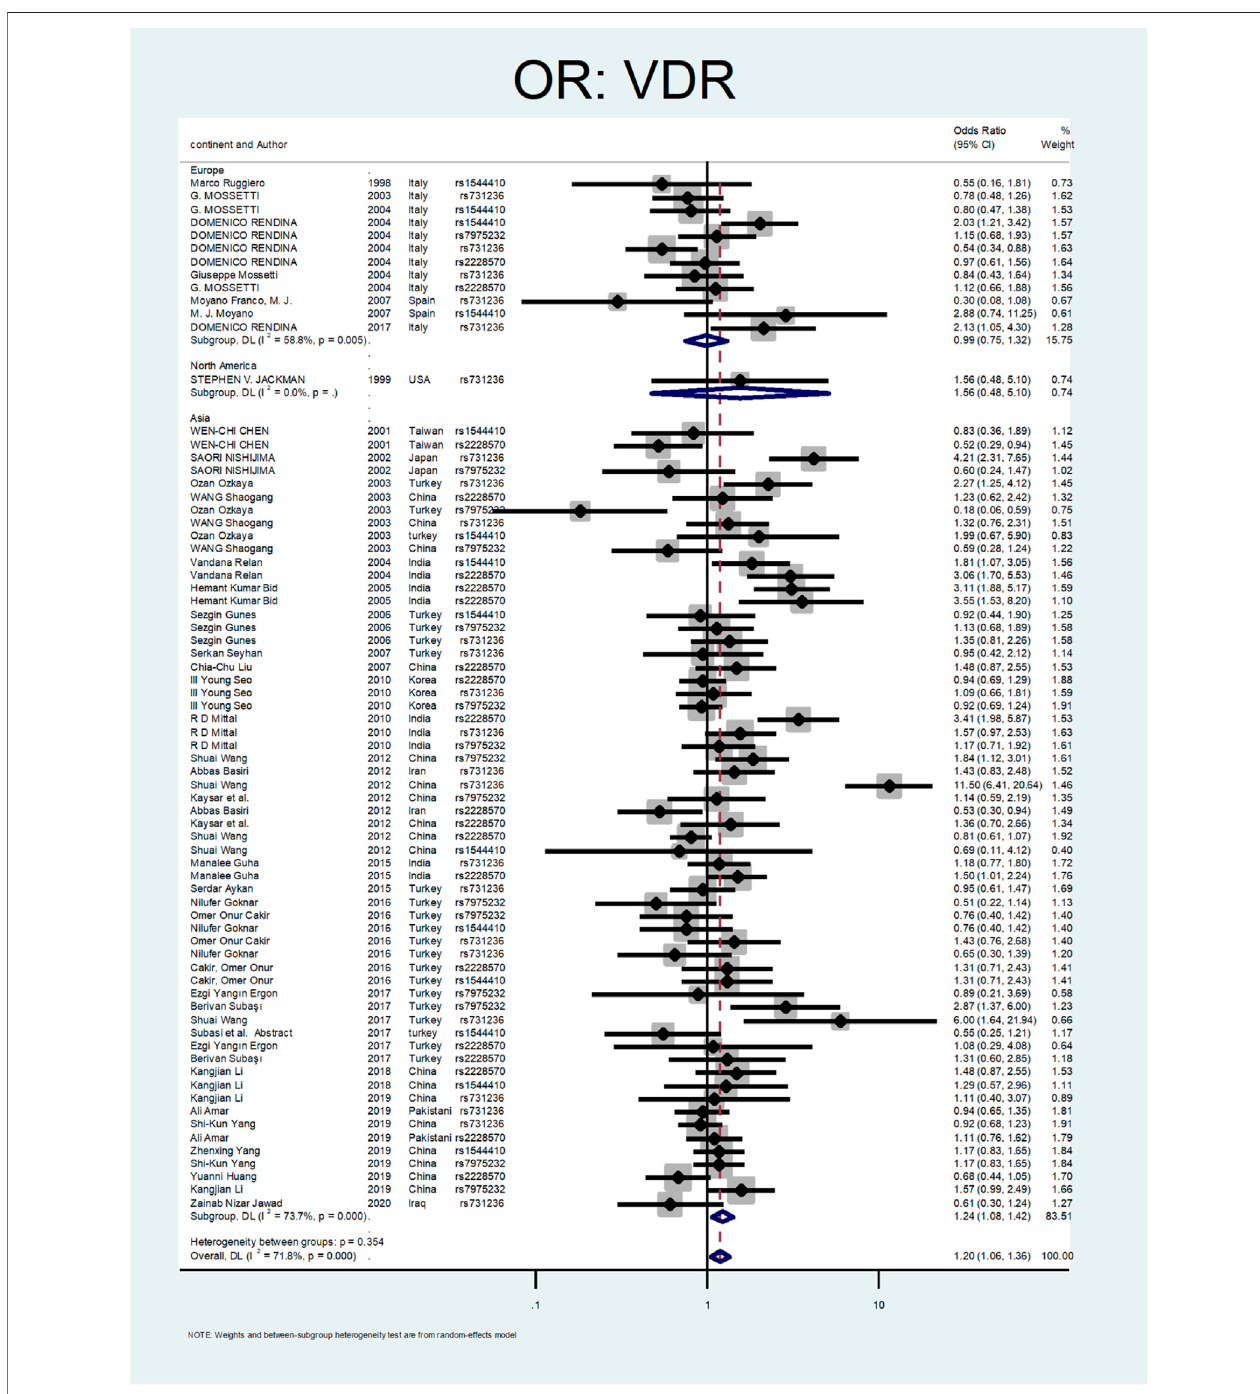
FIGURE 3 | Subgroup analysis for VDR, by